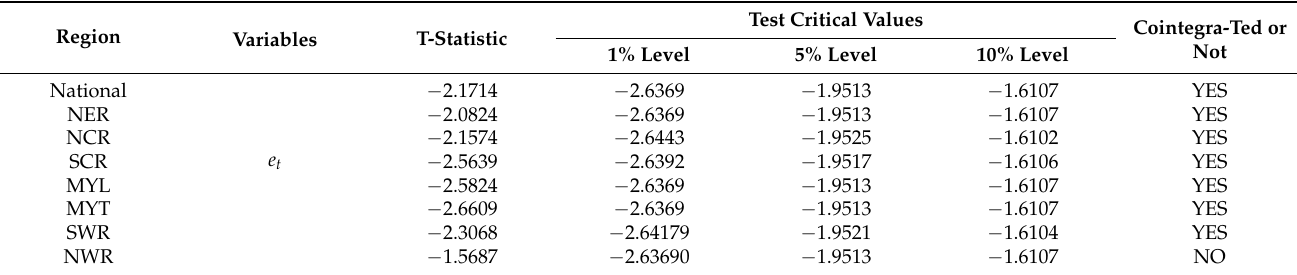
Table 6. Results of the panel cointegration test.